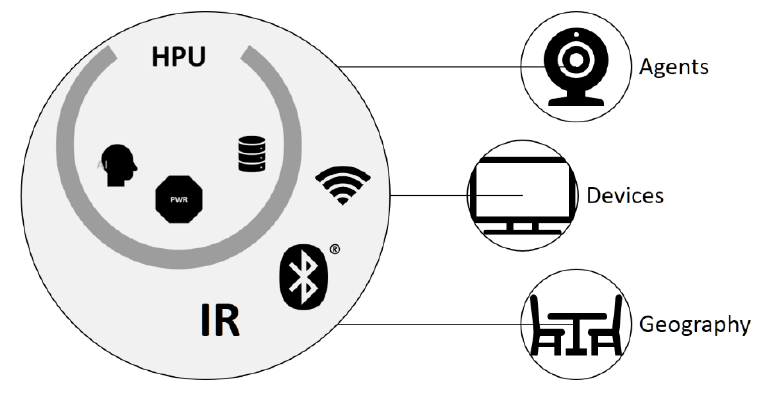
Figure 3. The model of a wellbeing home.